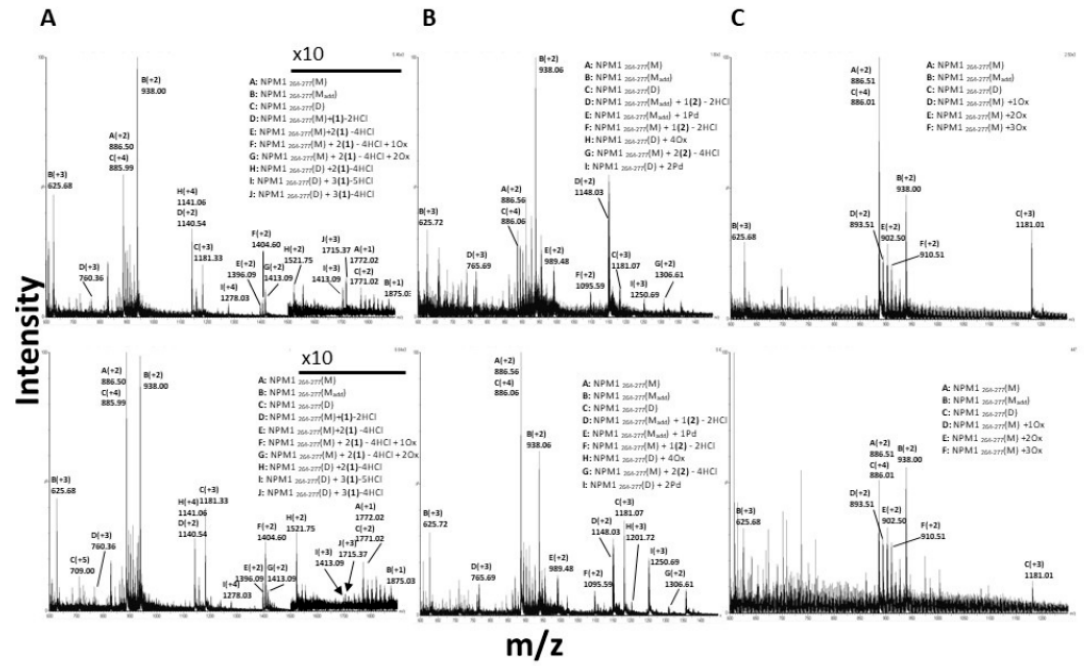
Figure 5. ESI-MS spectra of NPM1 264–277 incubated with: ( A ) 1 , at t = 0 (upper panel) and t = 17 h (lower panel), ( B ) 2 , at t = 0 (upper panel) and t = 17 h (lower panel), ( C ) 3 , at t = 0 (upper panel) and t = 17 h (lower panel). In panel A, the m / z range between 1500 and 1900 is 10 times magnified.